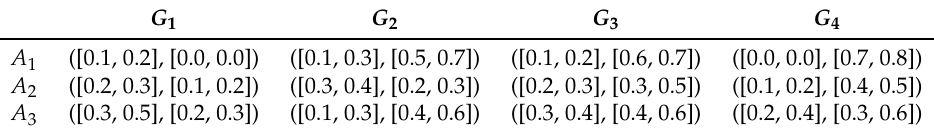
Table 3. Assessment of hydrogen production technology